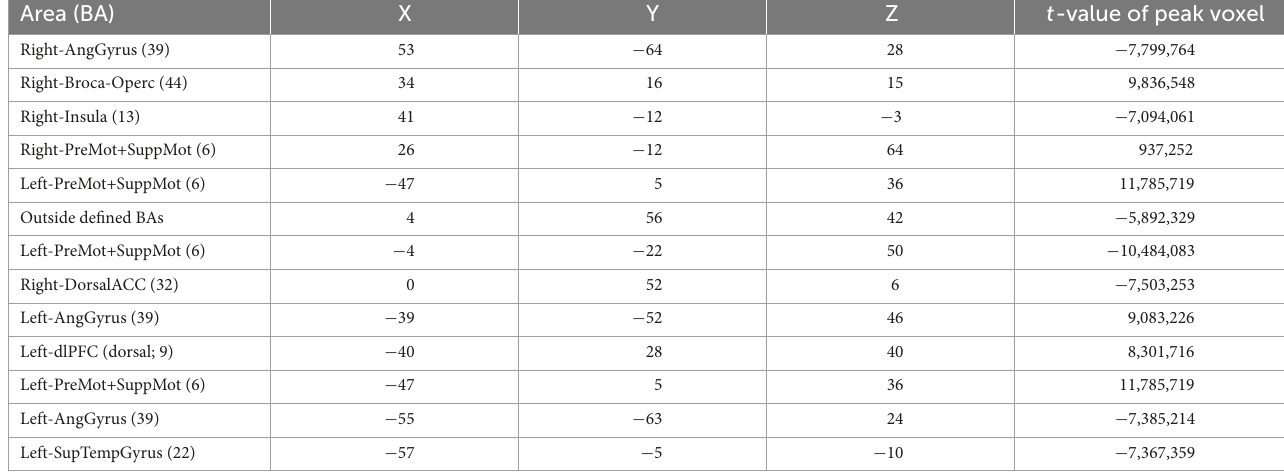
TABLE1 ClustersfromWhole-BrainAnalysis,activefeedbackgroup,imagery > baseline,FDR( q